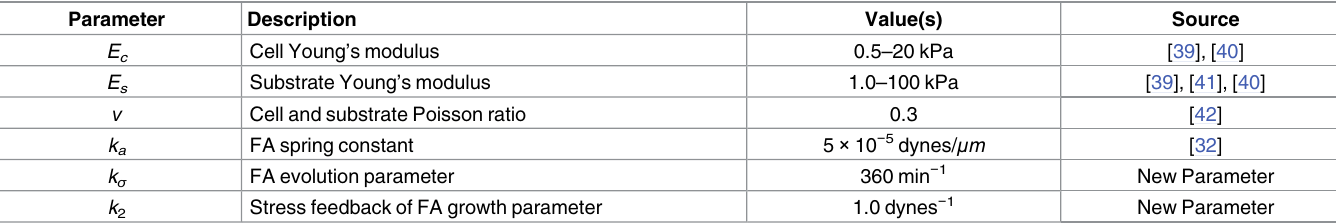
Table 1. Parametervalues used in